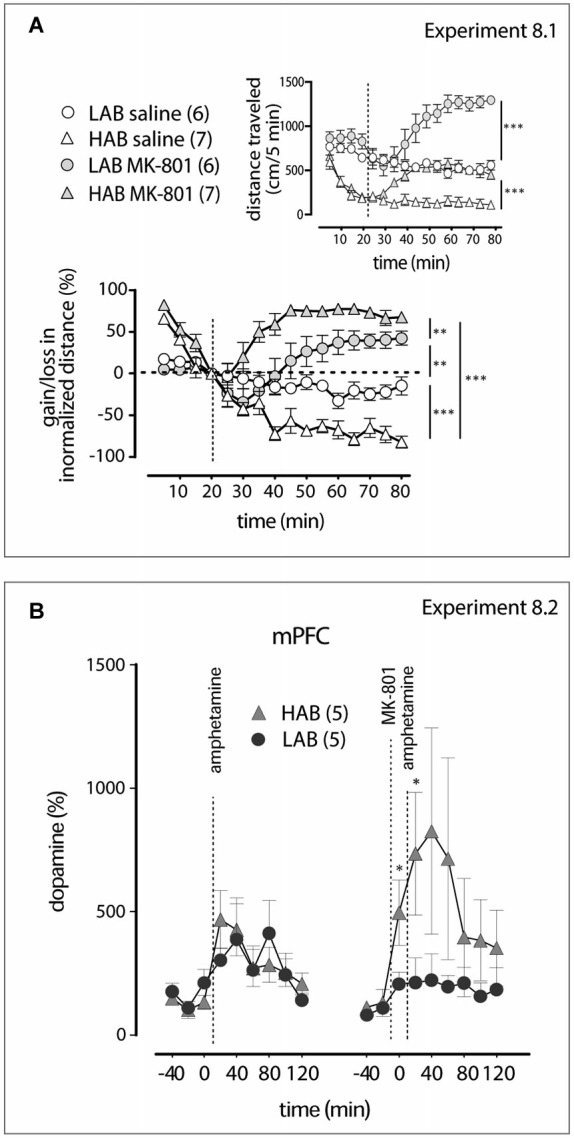
MK-801 shows different activities in LAB and HAB mice (A). Relative increase in locomotor activity induced by the NMDA receptor antagonist MK-801 is more pronounced in HAB (triangles) than in LAB (circles) mice. The dashed lines mark the moments of saline or MK-801 (0.3 mg/kg, i.p.) administration. The inset graph represents changes in the absolute values of the distance traveled. **p < 0.01, ***p < 0.001). (B). As revealed by in vivo microdialysis, pre-treatment (−20 min) with MK-801 facilitates dopamine release in the mPFC of HAB (triangles), but not of LAB (circle), mice. The dashed lines mark the moments of amphetamine (1 mg/kg, i.p.) and MK-801 (0.3 mg/kg, i.p.) administrations. *p < 0.05 vs. LAB mice.